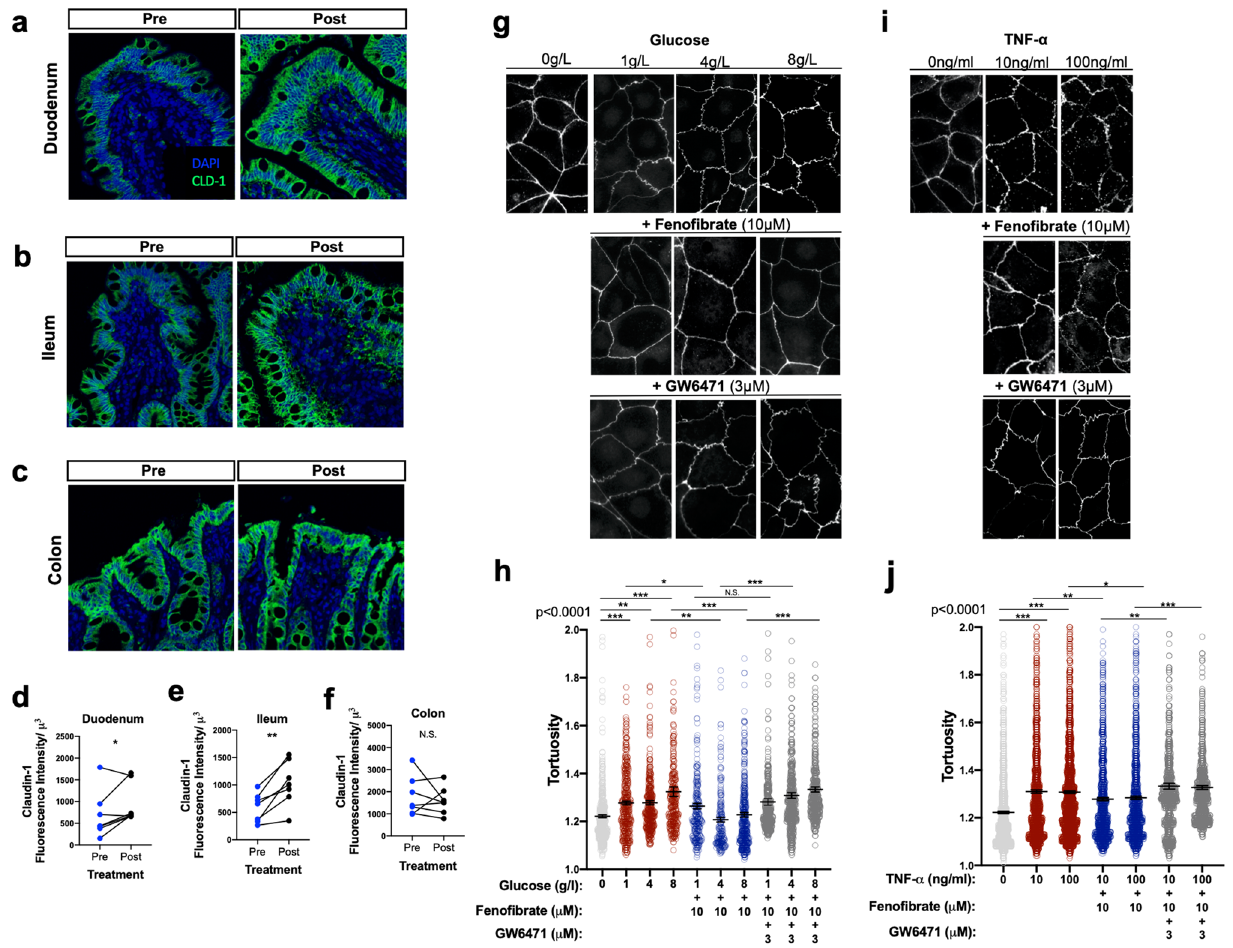
Figure 4. Fenofibrate upregulates expression of tight junctions on intestinal epithelial cells. Immunofluorescent staining of claudin-1 (CLD-1) expression in the ( a ) duodenum, ( b ) ileum, and ( c ) colon of diabetic dogs Caco-2 cells treated with different concentrations of glucose + 10 μM fenofibrate + 3 μM GW6741 or ( i , j ) TNF-α + fenofibrate + GW6741 for 24 h. * P < 0.05, ** P < 0.01, *** P < 0.001 by ( a – f ) mixed models ANOVA and ( g – j ) one-way ANOVA with Tukey’s multiple comparison test. N.S., not